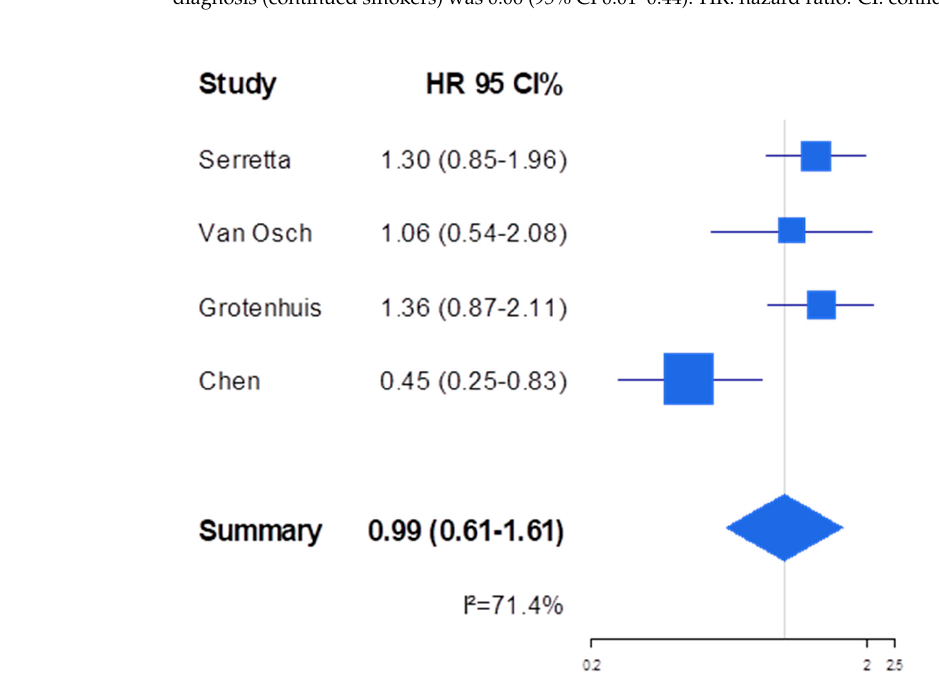
Figure 2. Forest plot for the association between quitting smoking at or around diagnosis (vs. continued smoking, taken as reference) and the risk of recurrence among bladder cancer patients. HR: hazard ratio. CI: confidence intervals.